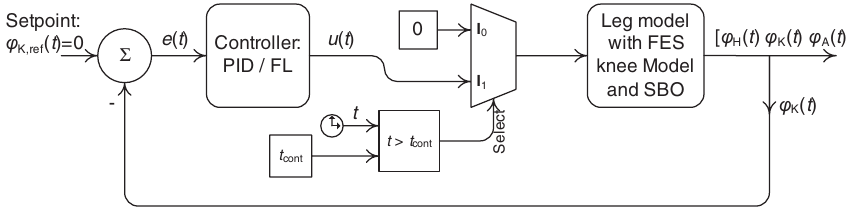
Fig. 8. Schematic of SBO control scheme-II: part-time closed-loop control with constant